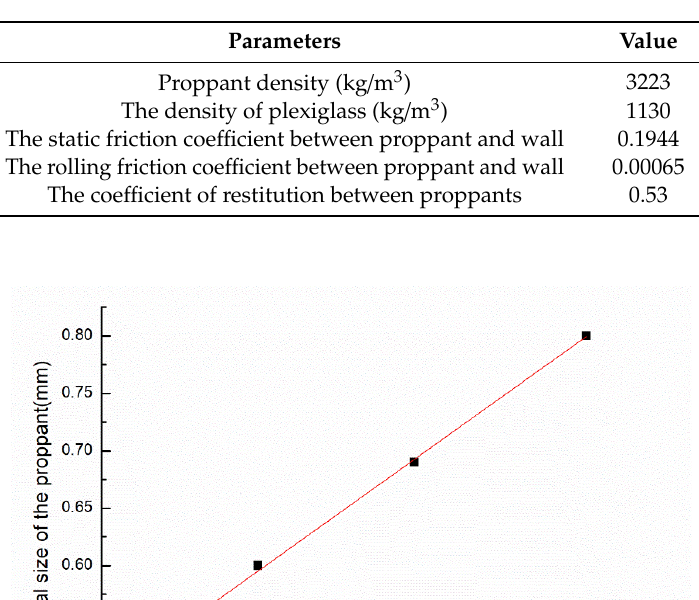
Table 5. Simulation